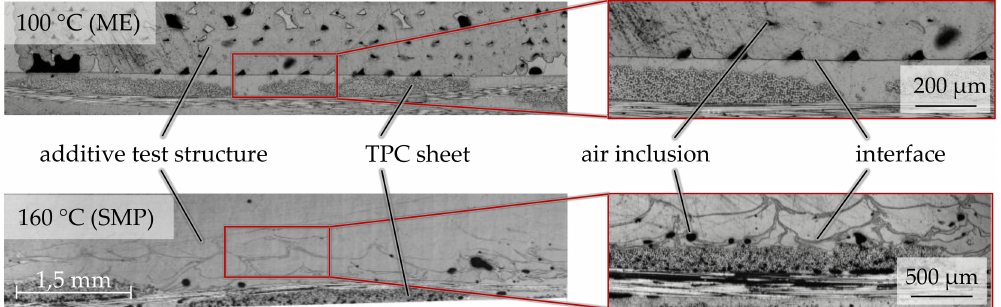
Figure 8. Samples of test specimen printed at 100 ( top ) and 160 ◦ C ( bottom